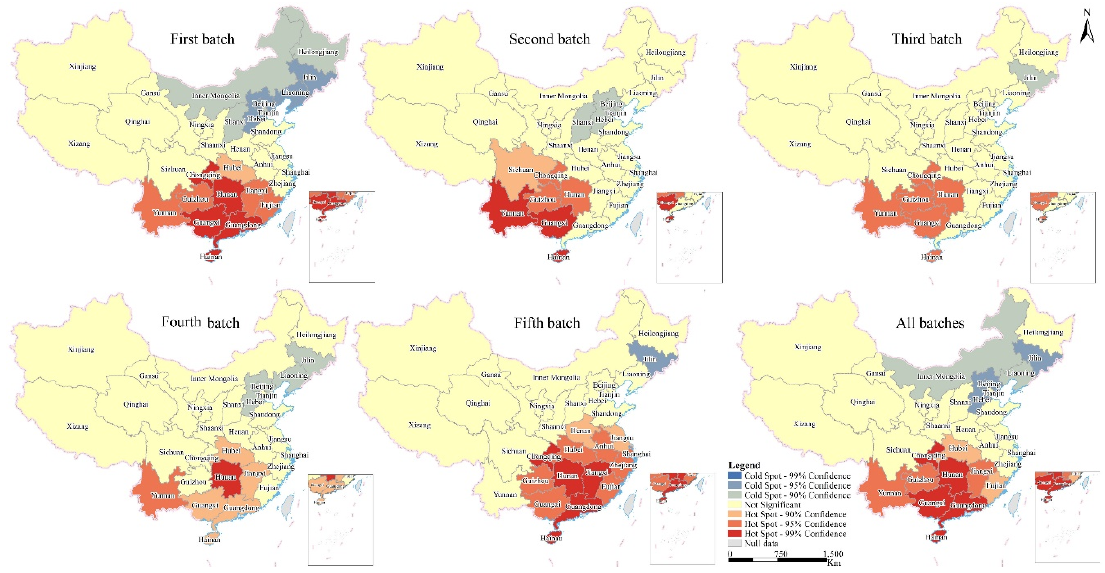
Figure 4. Spatiotemporal hot spot analysis at the provincial scale.